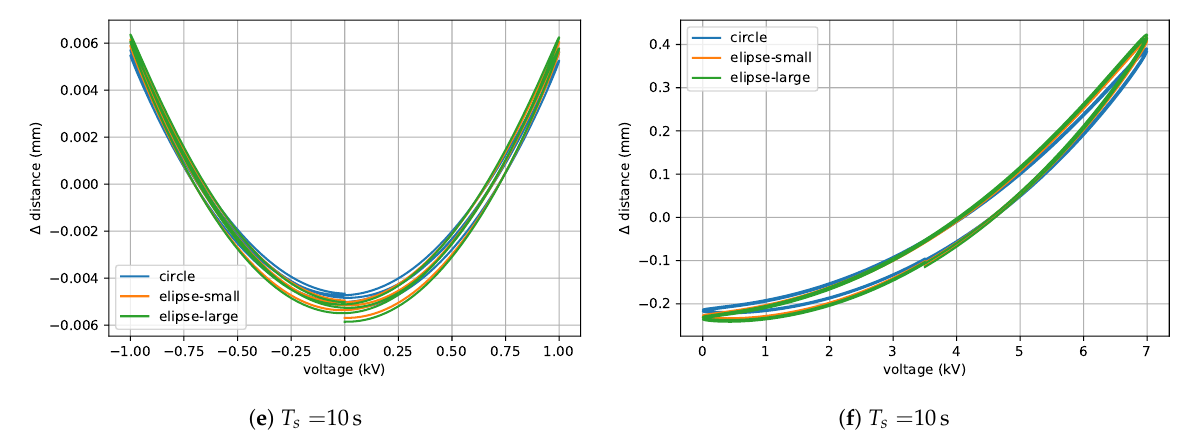
Figure 13. The hysteresis between voltage and distance for different types of actuator models. Zero level input signal u 0 = 0kV, u 1 = 1kV ( a , c , e ); nonzero level input signal u 0 = 3.5kV, u 1 = 3.5kV ( b , d , f ).